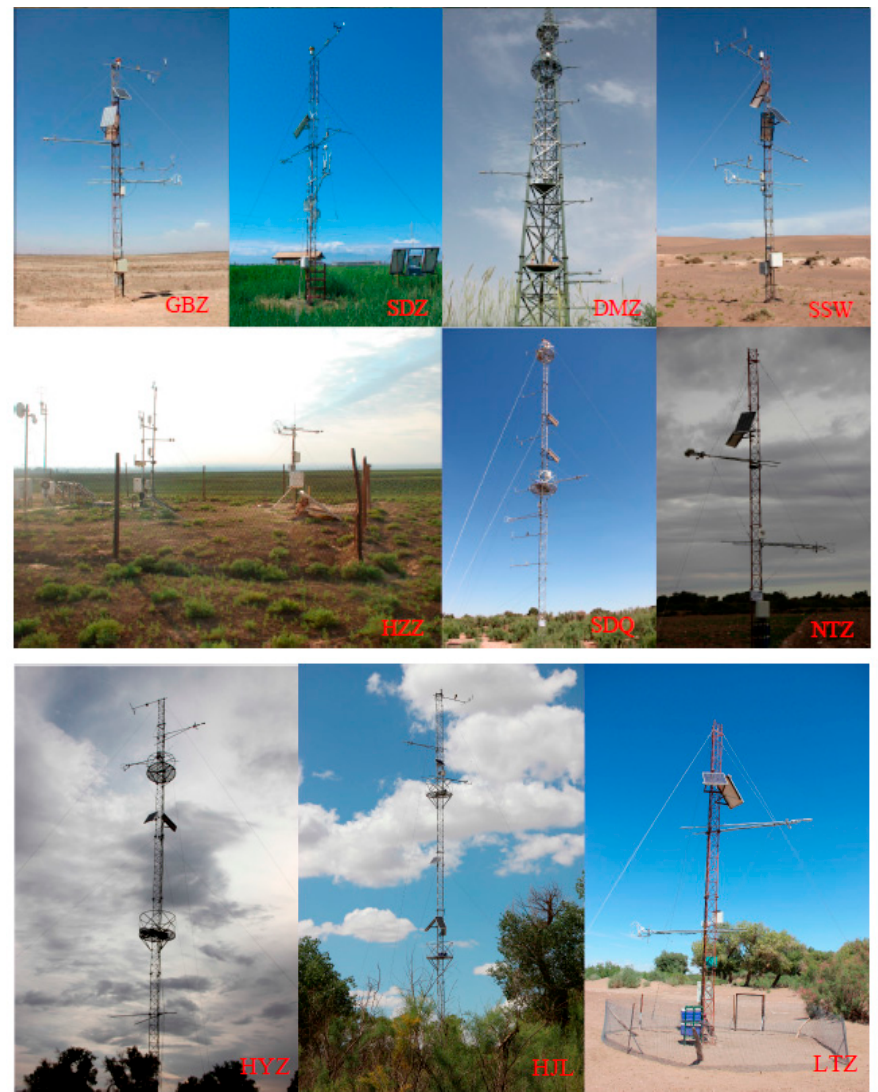
Figure 3. Photos of the 18 Heihe Watershed Allied Telemetry Experimental Research (HiWATER) stations. The two pyrgeometers that were used to record the longwave radiation were deployed at an average height of 6 m, with one facing upwards and the other facing